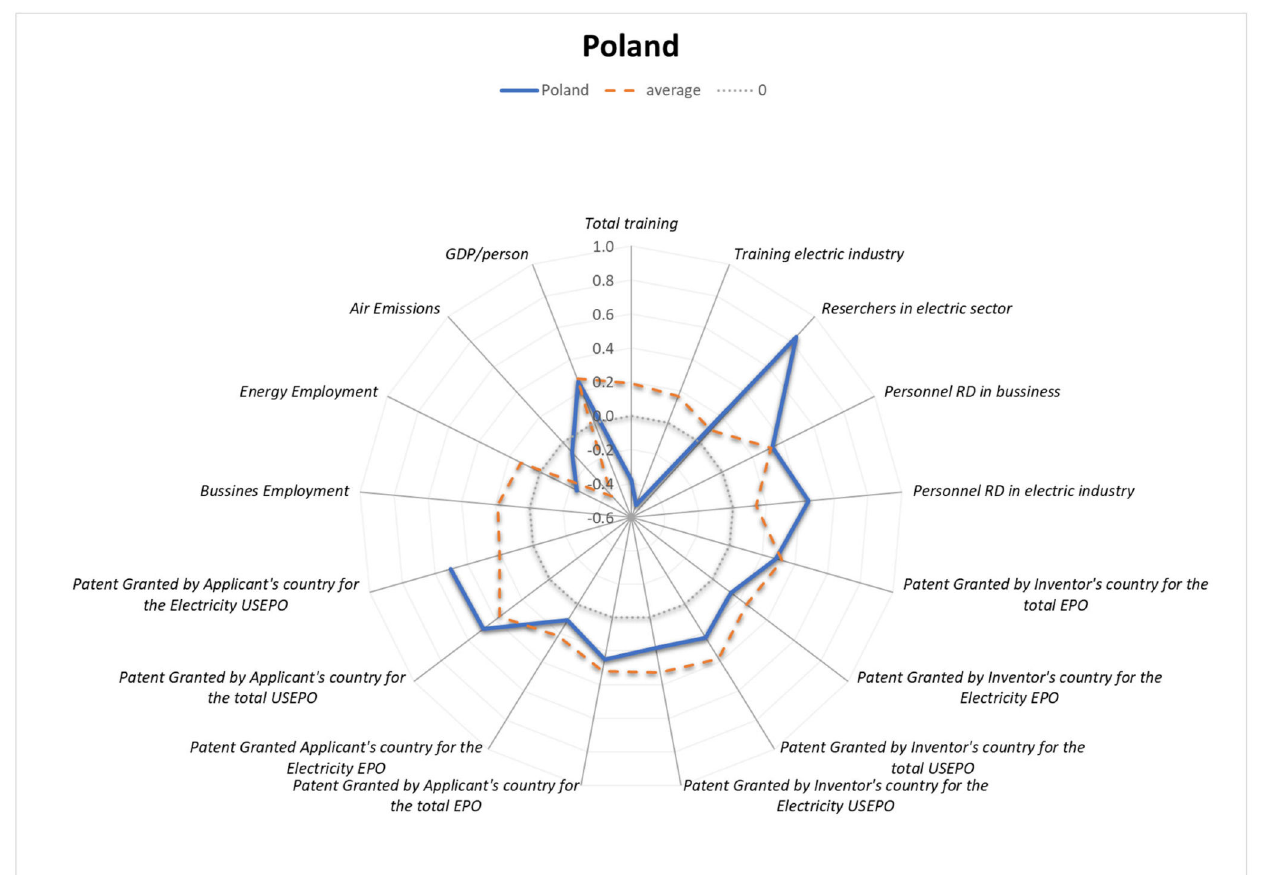
Figure 29. Synergy and trade-off occurrence—PL. Source: Authors’